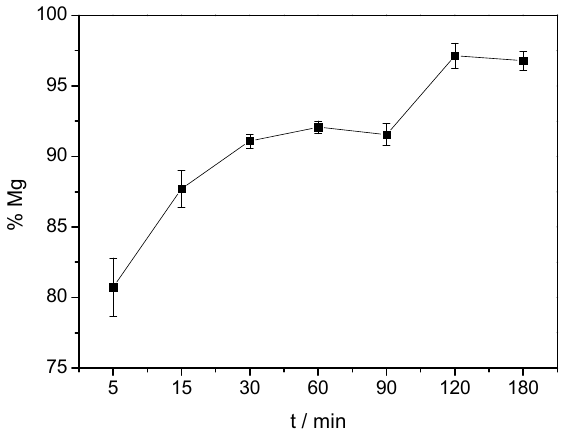
Figure 4. Mg extraction process curve as a function of reaction time.